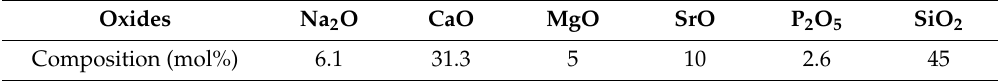
Table 1. Composition (in oxides mol %) of produced bioactive